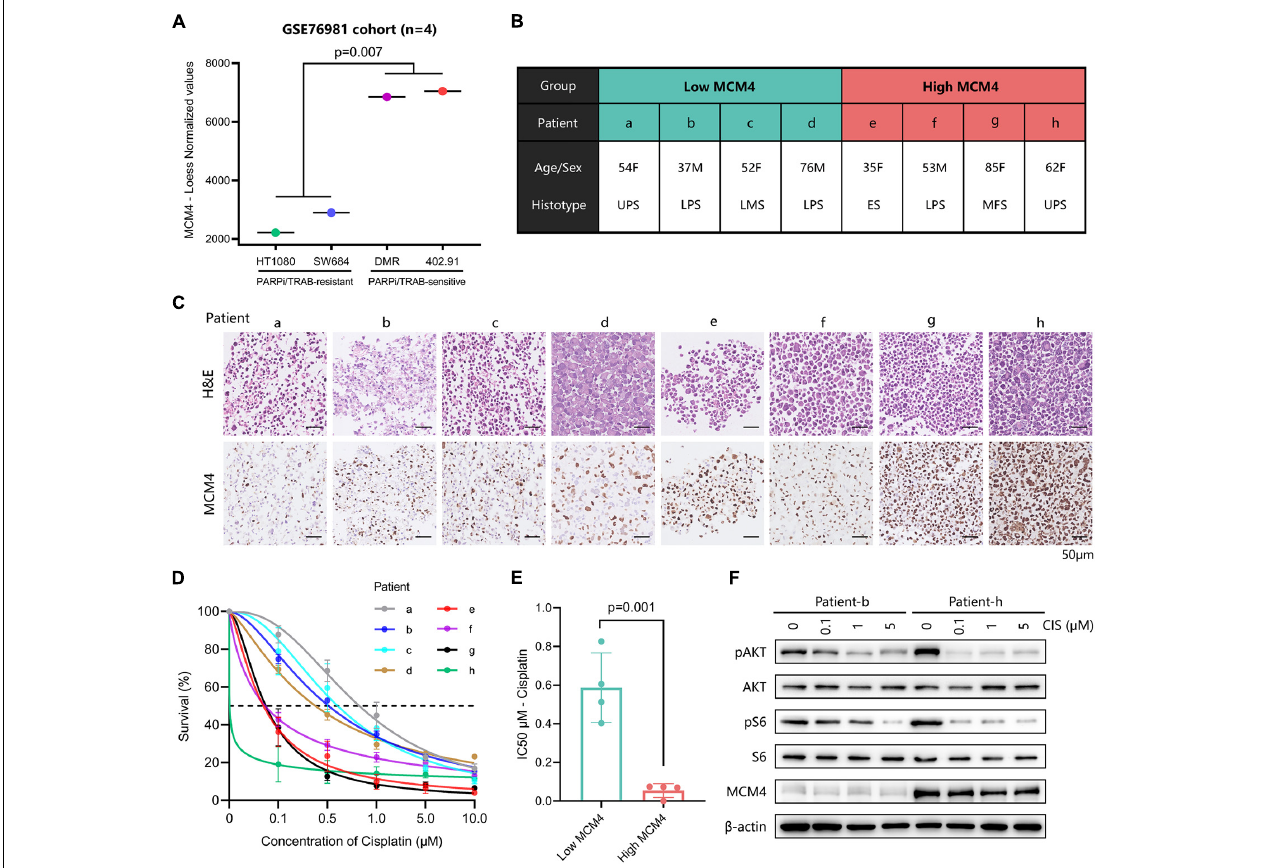
FIGURE 5 | Evaluation of the therapeutic potential in MCM4-high STS cell lines and patient-derived tumor cell cultures (PTCCs). (A) By comparing the gene expression profiles of four STS cell-lines, we found that MCM4 was drastically overexpressed in the PARPi/Trabectedin-sensitive cell lines compared with the PARPi/Trabectedin-resistant cell lines ( t -test, p = 0.007, n = 4). (B,C) Patient-derived tumor cell cultures (PTCCs) were established from the biopsy of eight STS patients, ranked by the corresponding tumoral MCM4 expression. After treated with cisplatin, the MCM4-high PTCCs (patient e–h) demonstrated less cell proliferation (D) , with a lower half inhibitory concentration (IC50) than the MCM4-low subset (a–d) ( t -test, p = 0.001, n = 8) (E) . Additionally, the levels of p-AKT and p-S6 were significantly reduced when cell growth was inhibited (F) .